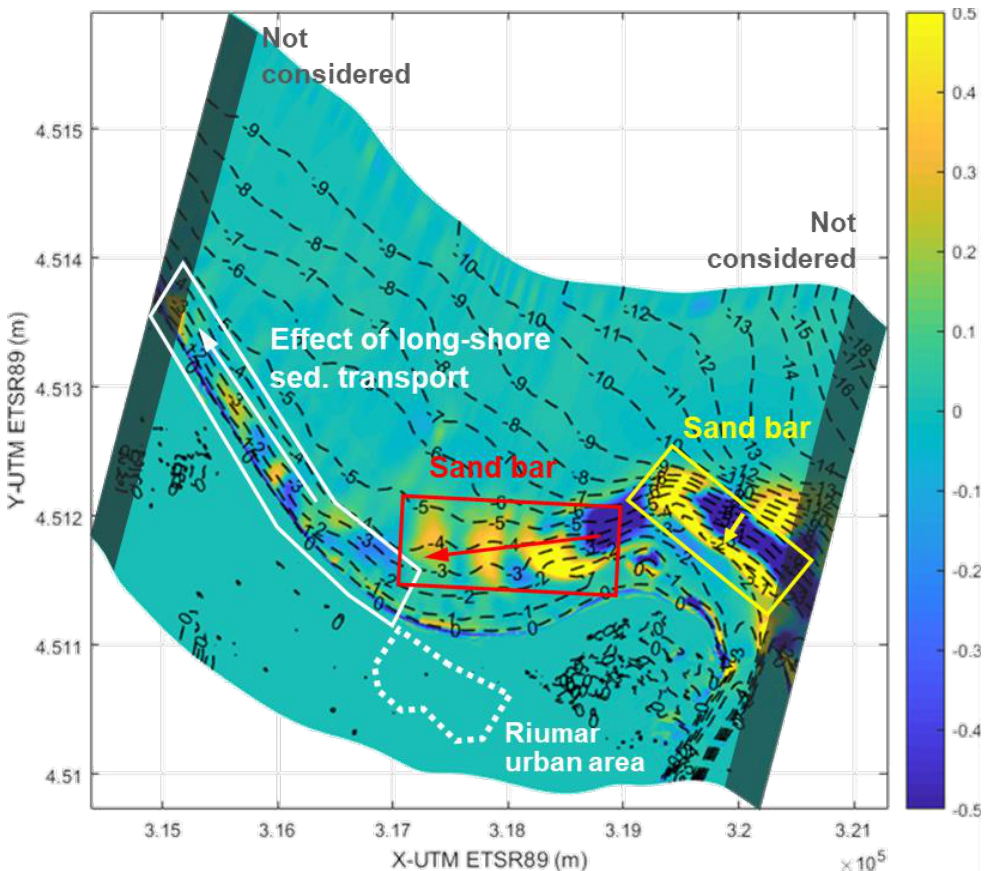
Figure 10. Post-storm erosion / accumulation patterns associated to scenario 1 (current climate without storm surge, SL = 0 m) due to the impact of an east-northeastern storm of 100-year return period. The areas where sediment is eroded are colored in deep blue while the areas where sediment is accumulated are shown in light yellow. Color bar (units in meters): in deep blue, accumulated erosion throughout the simulation; in light yellow, accumulated accretion. The shadowed western and eastern areas were not considered for the eroded volume